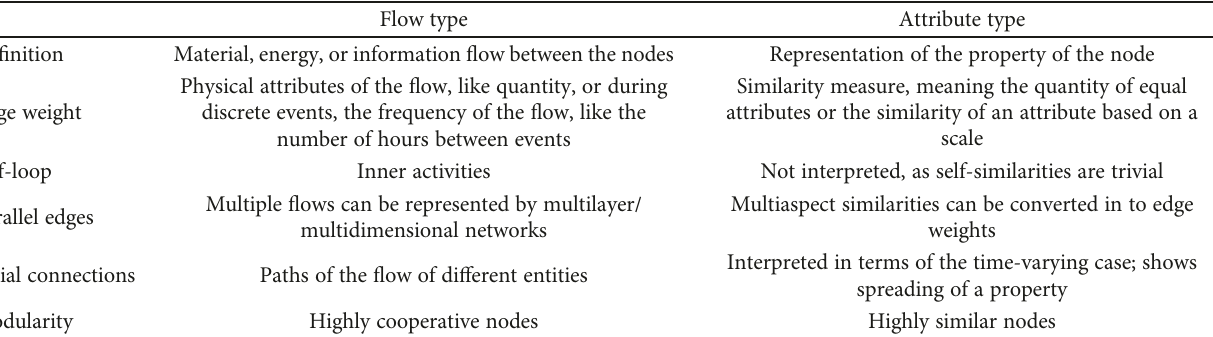
Figure 2: Visualization of the illustrative network as a multilayer/multiplex network highlights how the complex production system can be grouped into modules based on the “ viewpoints ” of the layers. Table 2: The edge types of the proposed multilayer